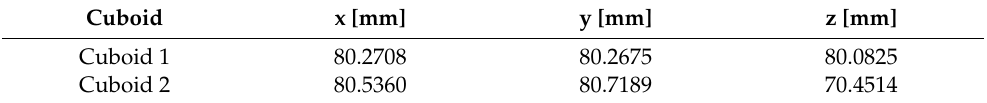
Table 1. Dimensions of the used cuboids (measured with touch probe).